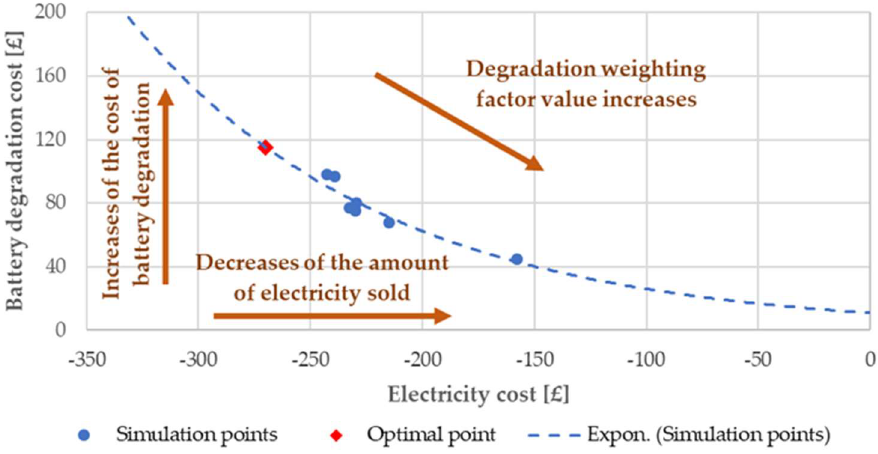
Figure 16. Electricity vs degradation cost with a varying weighting factor.